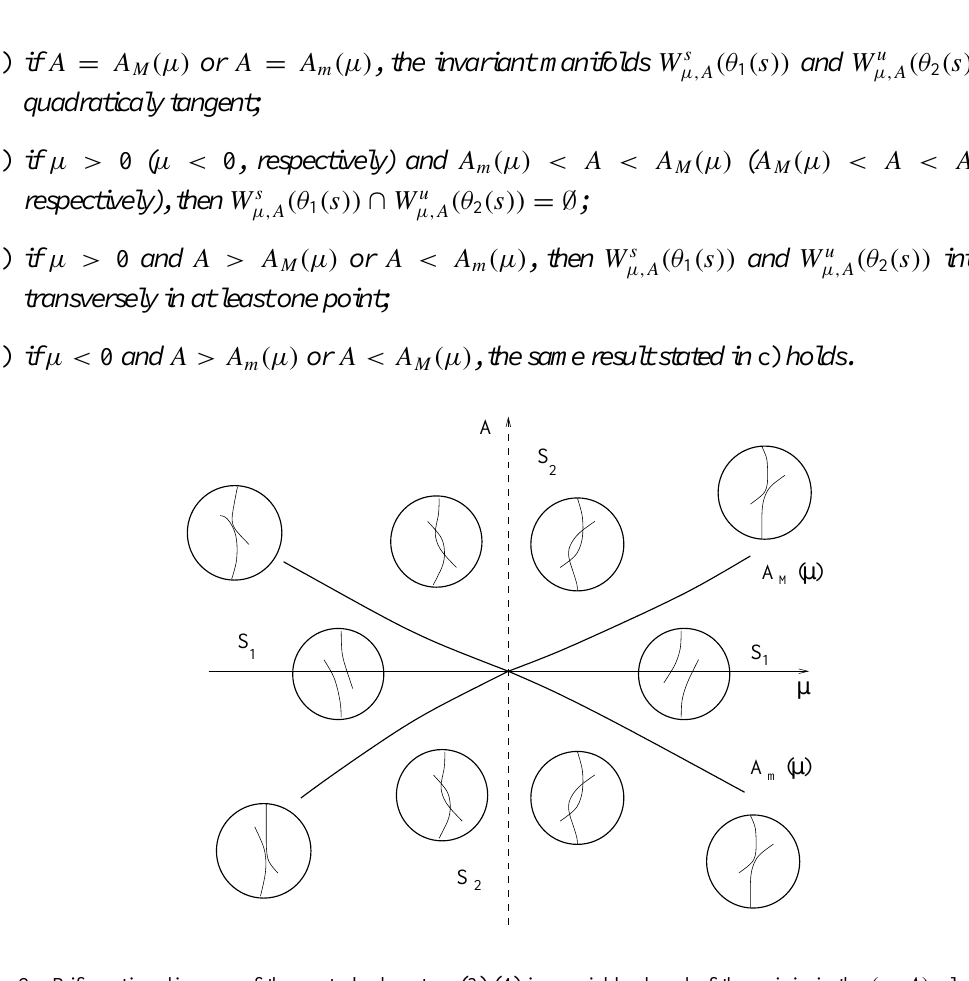
Fig. 2 – Bifurcation diagram of the perturbed system (3)-(4) in a neighborhood of the origin in the (µ,A) -plane. The relative position of the invariant manifolds W s (θ 1 (s)) and W u (θ 2 (s)) in a transversal cross section of the torus D 2 × S 1 are